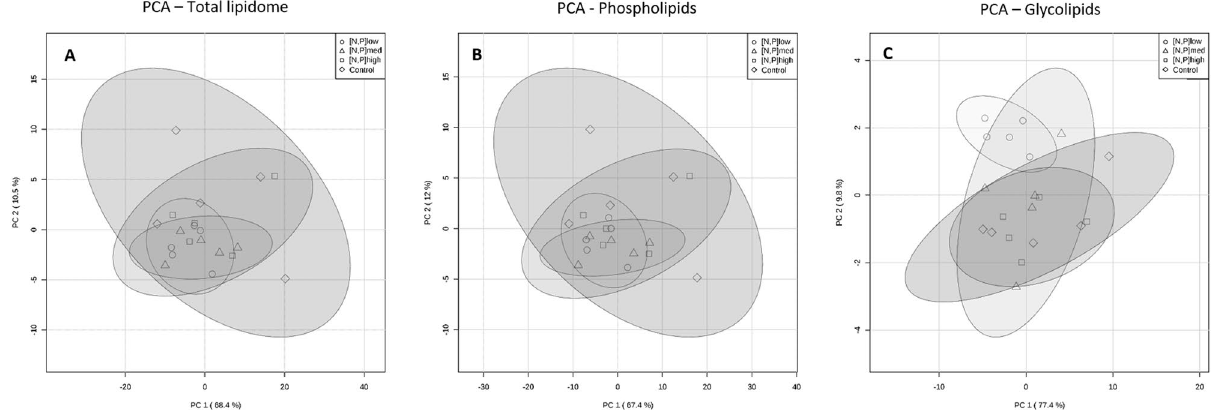
Figure 4. Principal component analysis ( PCA) scores plot of ( A ) total lipidome, ( B ) phospholipids and ( C ) glycolipids normalized peak-intensity, obtained from the lipid extracts from Halimione portulacoides